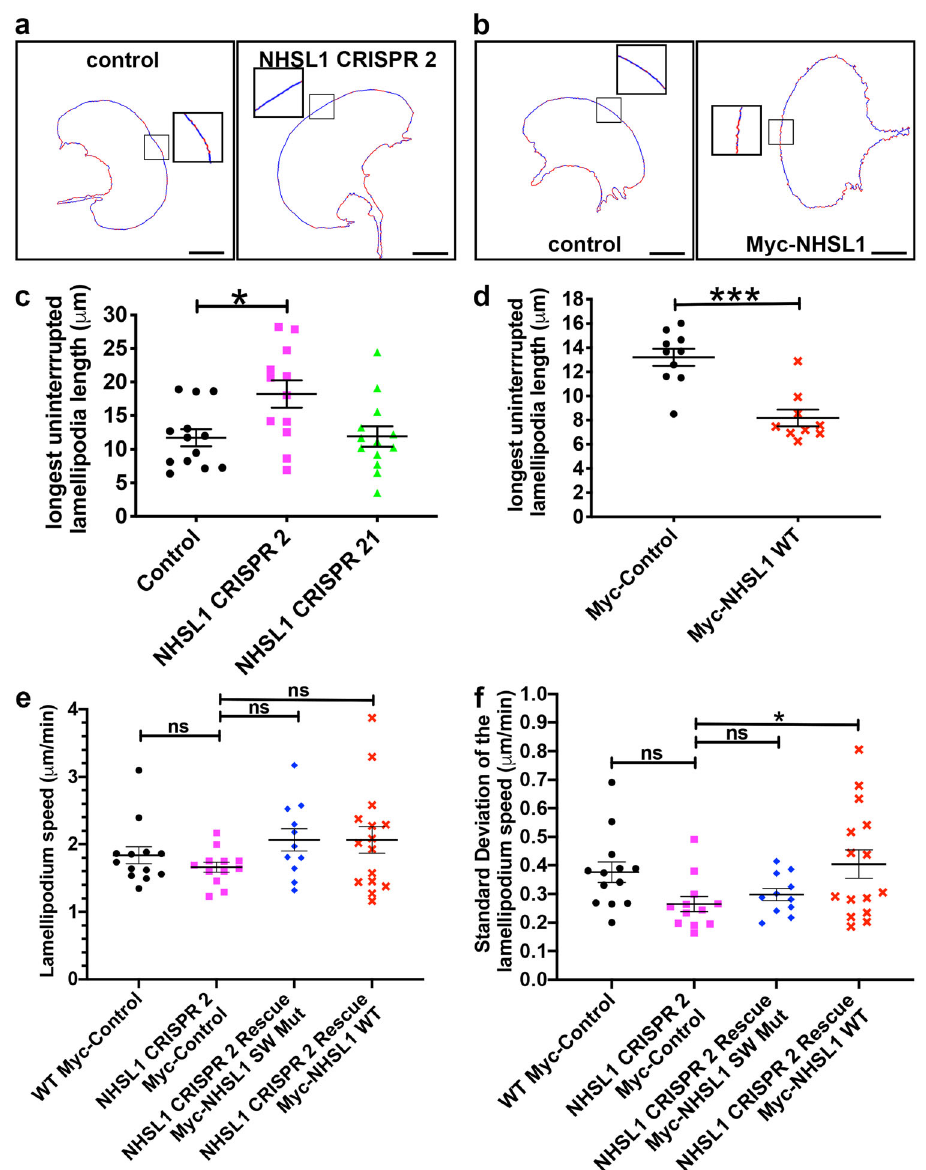
Fig. 10 NHSL1 reduces the stability of lamellipodia protrusion. a , b Movie stills showing protrusion (blue) and retraction (red) dynamics of wild-type B16- F1, NHSL1 CRISPR 2 and B16-F1 cells overexpressing Myc-tagged NHSL1. Scale bar: 20 μ m. c , d NHSL1 reduces the length of the longest uninterrupted lamellipodium. Each data point represents the mean length of the longest uninterrupted lamellipodium quanti fi ed from all frames of a movie of one LifeAct- EGFP expressing B16-F1 cell (5 s intervals, 10 min duration) (see ‘ Methods ’ for details). Control (black circles), NHSL1 CRISPR 2 (magenta squares), 21 (green triangles) ( c ) and control (black circles) and Myc-NHSL1 overexpression (red crosses) ( d ). c Control: n = 13; NHSL1 CRISPR 2: n = 12; NHSL1 CRISPR 21: n = 13 cells. One-way ANOVA: P = 0.0111; F (2,35) = 5.133; Dunnett ’ s test * P = 0.0144, control versus CRISPR 21: not signi fi cant: ns P = 0.9949. d control n = 10; Myc-NHSL1 n = 9 cells. *** P = 0.006, Mann – Whitney test. e , f Quanti fi cation (see ‘ Methods ’ section) of lamellipodia protrusion speed ( e ) and lamellipodia stability ( f ) of randomly migrating wild-type B16-F1 cells or CRISPR 2 cells expressing either NHSL1 (NHSL1 WT) or the NHSL1 mutant in the Scar/WAVE complex binding sites (NHSL1 SW Mut) or Myc alone (control) plated on laminin. WT Control: n = 13, NHSL1 CRISPR 2: n = 12,